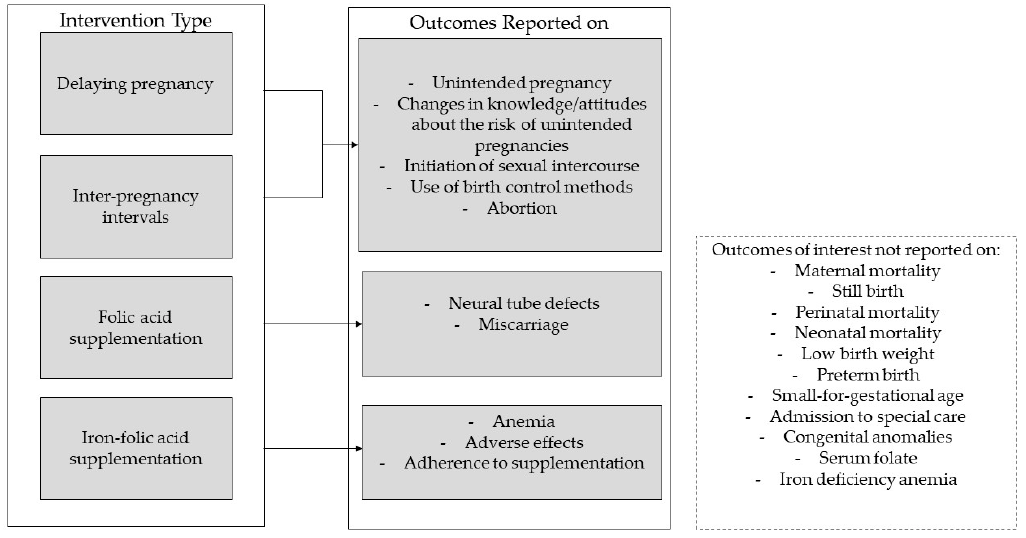
Figure 1. Intervention types with associated outcomes.